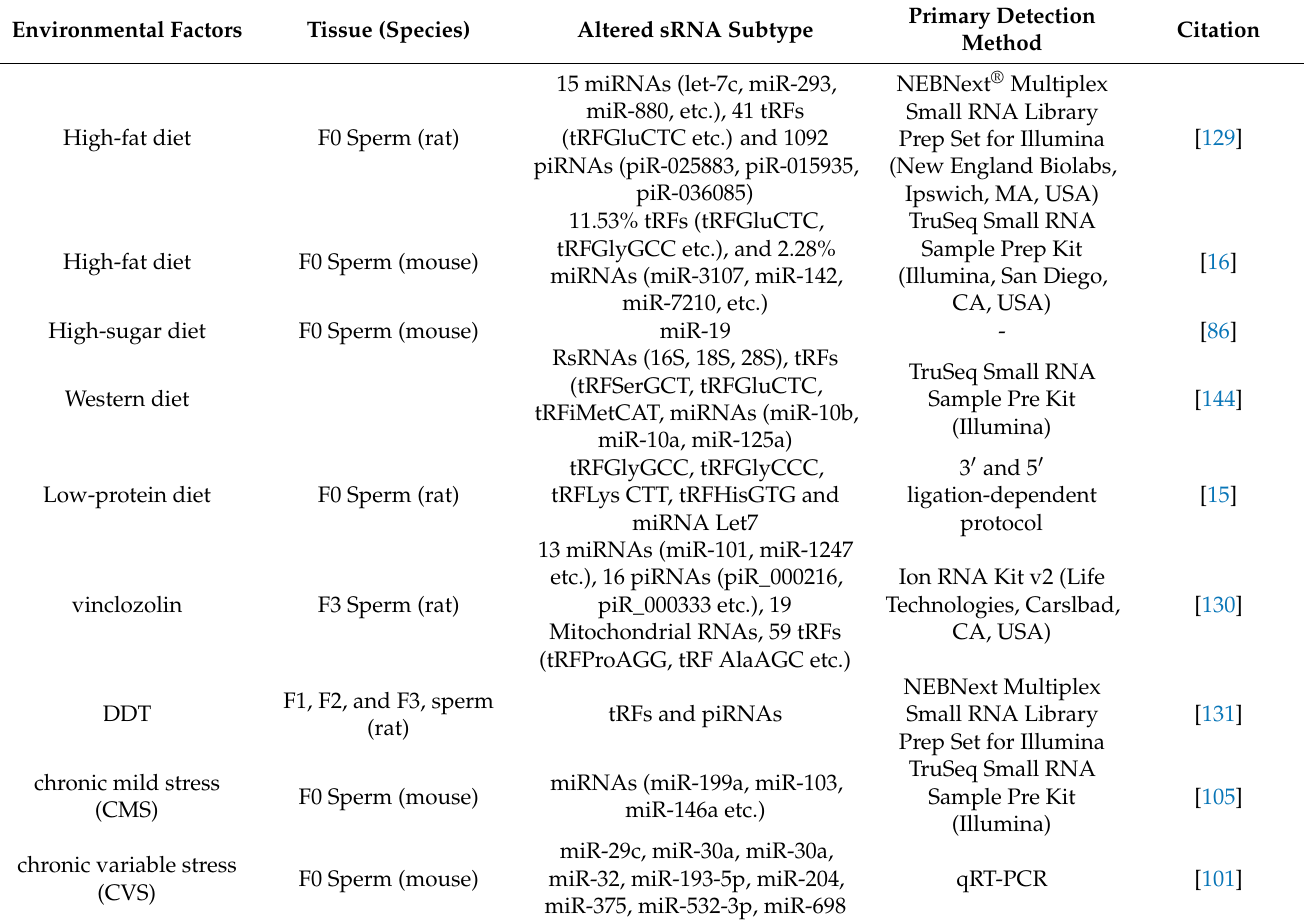
Table 2. Overview of the different classes of sRNAs altered in sperm of animals exposed to various environmental conditions. NA: Information about sRNA sequencing method not